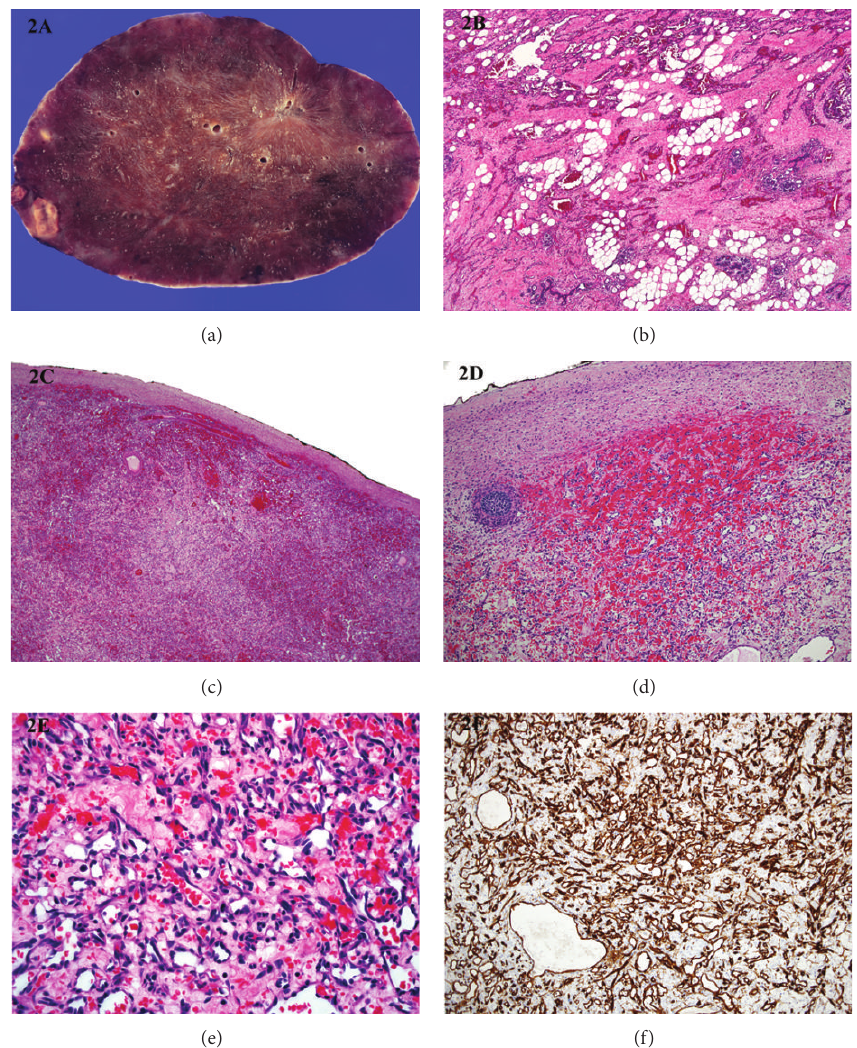
Figure 2: (a) Gross photograph of a transverse section of the large 14 × 10 × 6cm ovarian mass. This lesion is seen to essentially replace the entire ovary and is composed of fleshy, deep red tissue. The ovarian surface is smooth and the capsule is grossly intact. There are areas of pallor and an area of necrosis at the left. (b) Histology from the previous mastectomy specimen shows extensive angiosarcoma within the deep breast parenchyma comprising irregularly anastomosing vascular channels lined by spindle cells with hyperchromatic nuclei. There is some preservation of breast lobular units (bottom right of field). (c) The subsequent oophorectomy specimen shows almost complete effacement of the ovarian parenchyma by similar angiosarcoma. Note the completely intact capsule and absence of tumor on the ovarian surface. (d) Only tiny amounts of peripheral ovarian parenchyma remain: a thin rim of ovarian tissue is seen peripherally and an intact follicle is seen on the left. The tumor is well differentiated and extensively vasoformative, with formation of blood lakes. (e) At higher power, the vascular channels are lined by mildly to moderately atypical spindle cells. (f) The cells are diffusely positive for